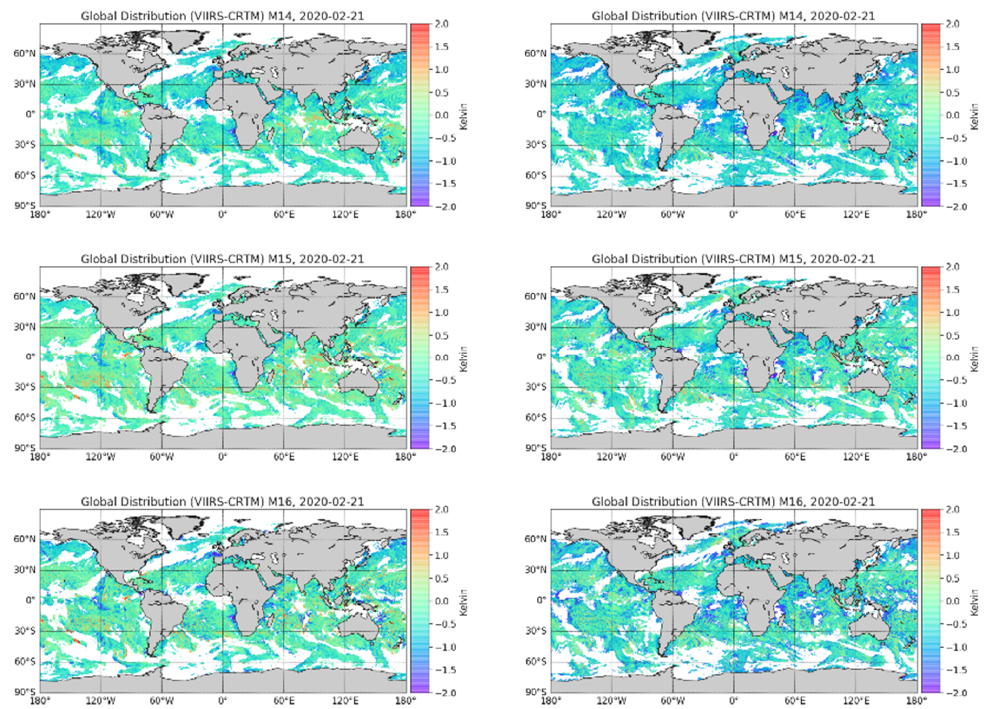
Figure 2. Global distribution of the O-M biases on 21 February 2020 for VIIRS M14 ( top ), M15 ( middle ), and M16 ( bottom) , using FCDN_CSM as clear-sky identification for both daytime ( left ) and nighttime ( right ).